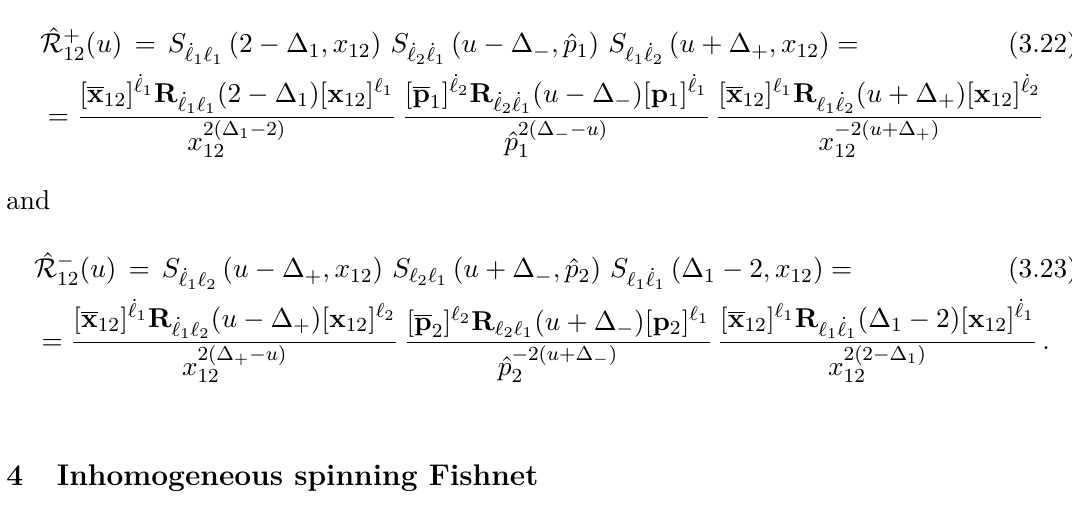
ˆ Figure 14 . Left: the kernel of the general R -operator in diagram formalism. It can be factorized into the product of two integral kernels ˆ R . Center: integral kernel of the operator ˆ R ± integral kernel of the operator ˆ R ( u ) . When multiplied, the horizontal red/green lines in the two + triangular kernels simplify, as their power is opposite as well as the argument of the two R -matrices involved (see (2.22)) and the kernel of ˆ R ( u ) is